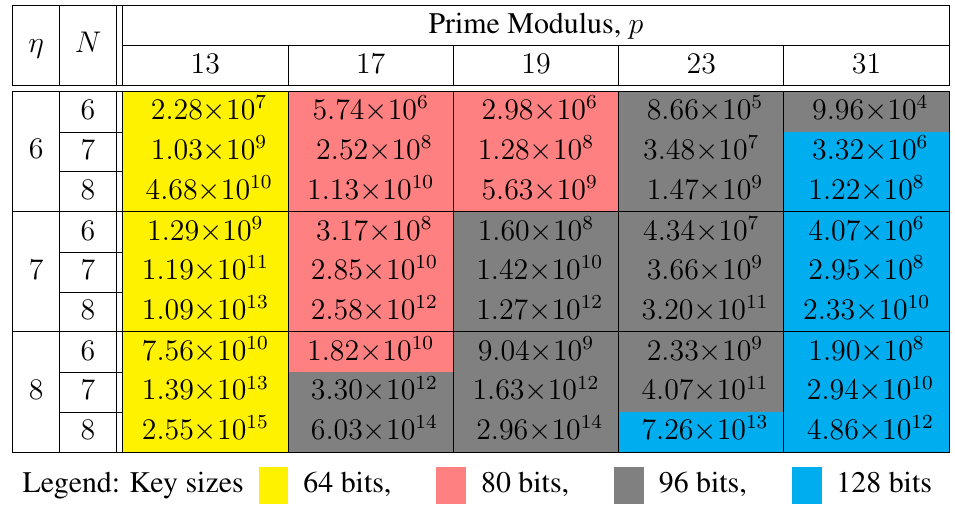
Table 3. Capture sizes n